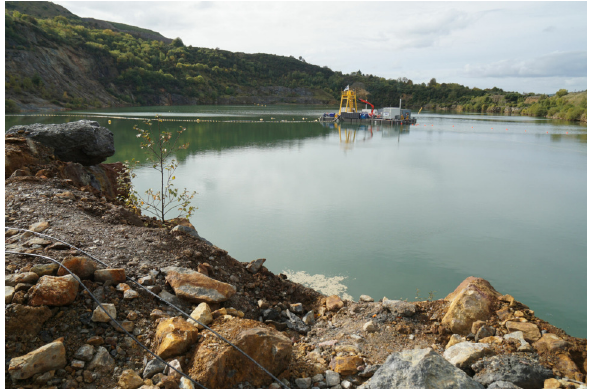
Figure 1. ¡VAMOS! underwater mining system deployed during a field test in Silvermines,